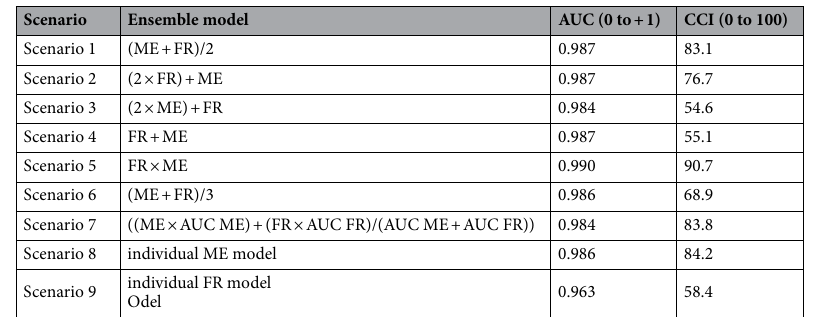
Table 1. Predictive performance of models in ensemble